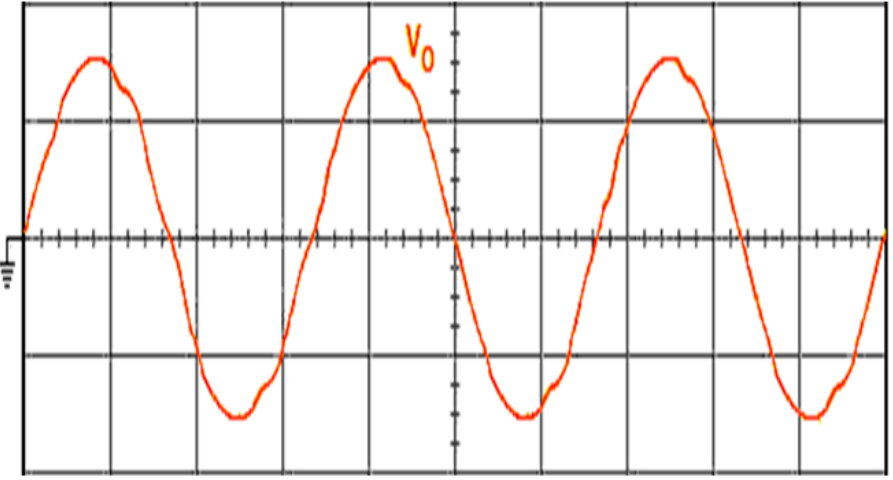
Figure 12. Experimental waveform under an LC variation for the classic FTCC (100 V/div; 5 ms/div).